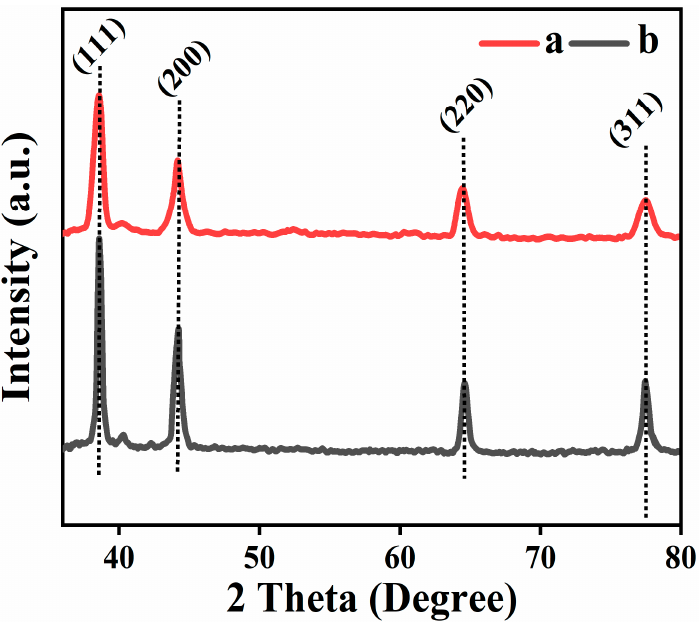
Figure 2. XRD patterns of synthesized NPs (a) R-Ag-Nps and (b) L-Ag-Nps.